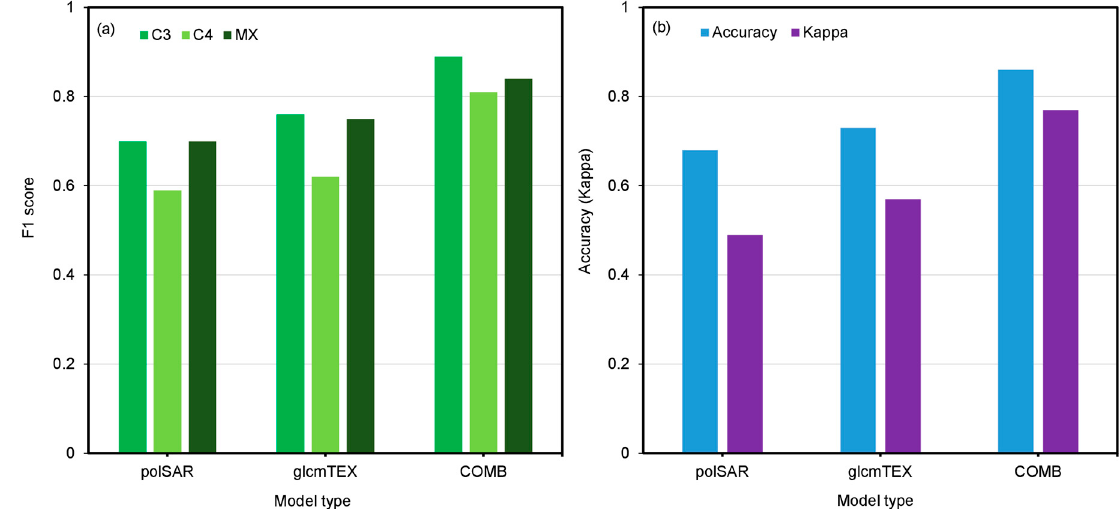
Figure 6. Evaluation of random forest classification models using the F1 score, accuracy, and the Kappa coefficient. The random forest models, as defined by the type of features used, are expressed on the x -axis as: ( a ) polarimetric SAR features (polSAR), ( b ) textural features from grey-level co-occurrence matrix (glcmTEX), and ( c ) the combination of polSAR and glcmTEX features (COMB).